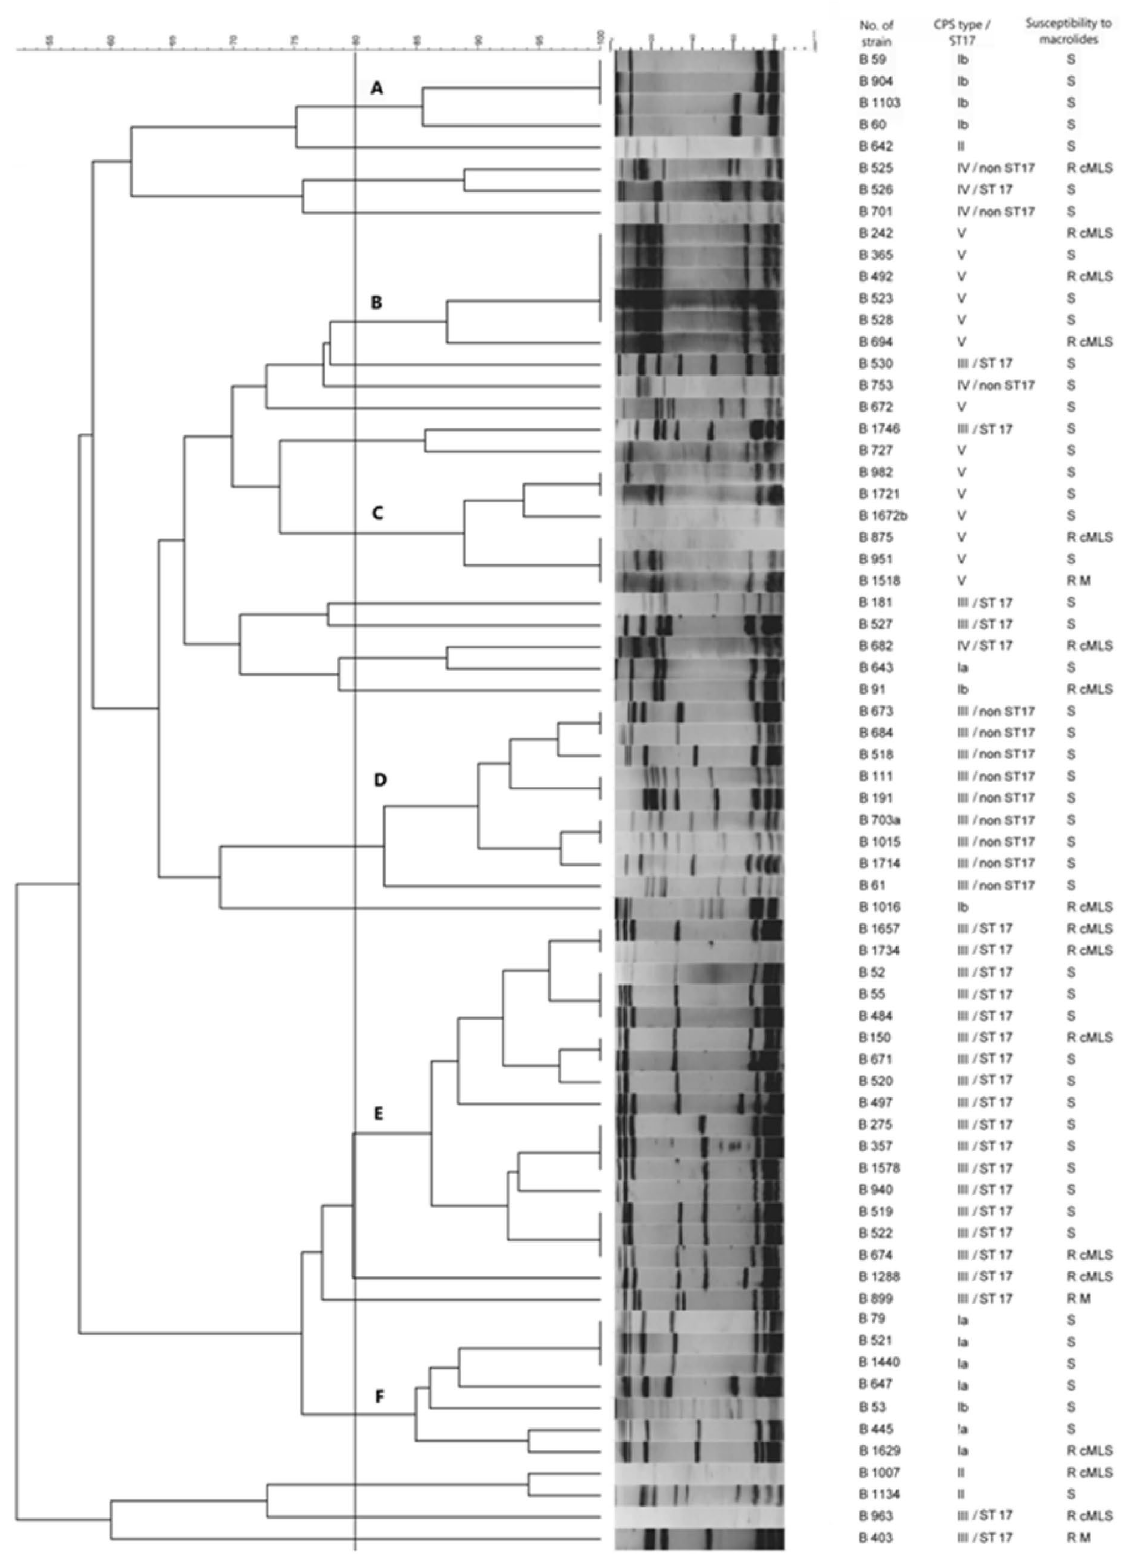
Figure 2. Dendrogram showing the genetic relationship of 69 invasive isolates of Group B streptococci established from PFGE patterns obtained after SmaI digestion. Dendrogram and PFGE patterns of SmaI-digested chromosomal DNA of Group B streptococci and association with capsular polysaccharide types, susceptibility to macrolides, macrolide resistance phenotypes, and the number of isolates belonging to these genotypes. The dendrogram was constructed with BioNumerics software, with 1.5% position tolerance, by using the UPGMA algorithm and Dice similarity coefficients. The clusters (clusters A, B, C, D, E, and F) contained isolates with similarity coefficients greater than 80% (indicated by the vertical line). Full-length gels are presented in Supplementary Data—Figures S4, S5,